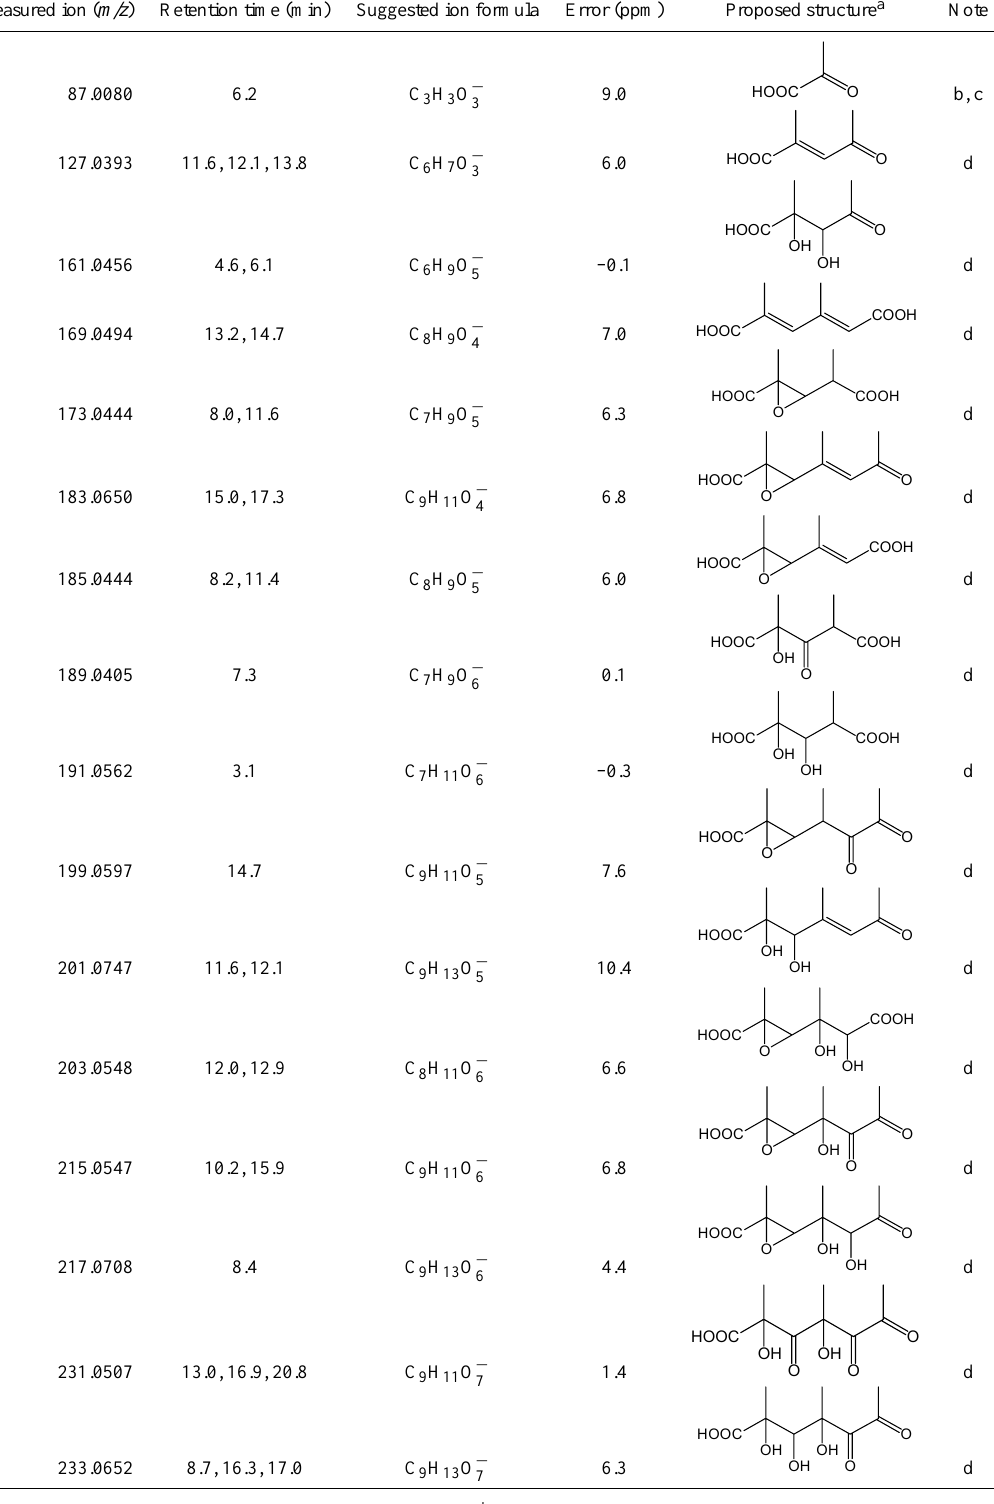
Suggested Error Proposed Structure a Note Ion Formula (ppm)